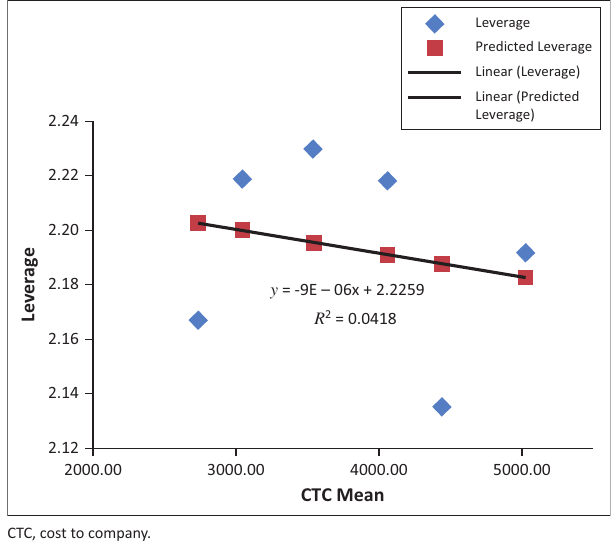
CTC, cost to company. FIGURE 9: Regression of leverage mean on cost to company mean.